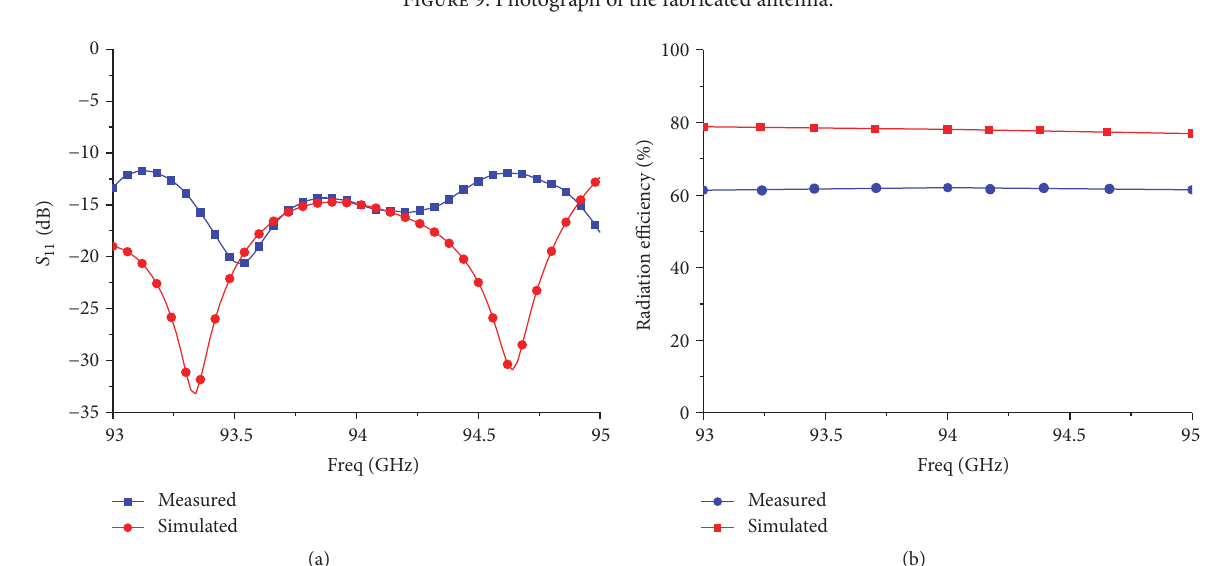
Figure 10: (a) Return loss of the fabricated antenna. (b) Radiation efficiency of the